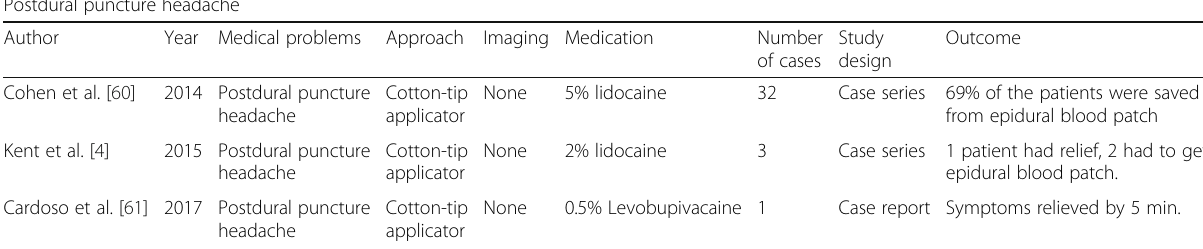
Table 10 Studies of SPG blocks for postdural puncture headache Postdural puncture